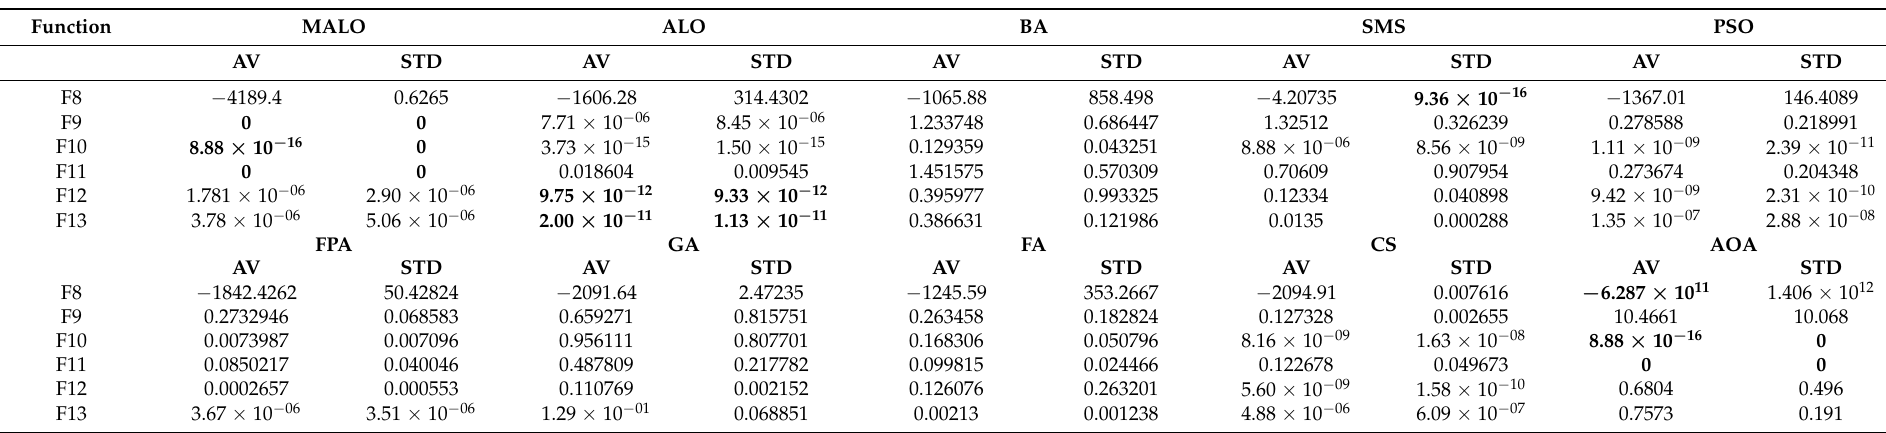
Table 6. Results of malo and other algorithms for multimodal functions (1000